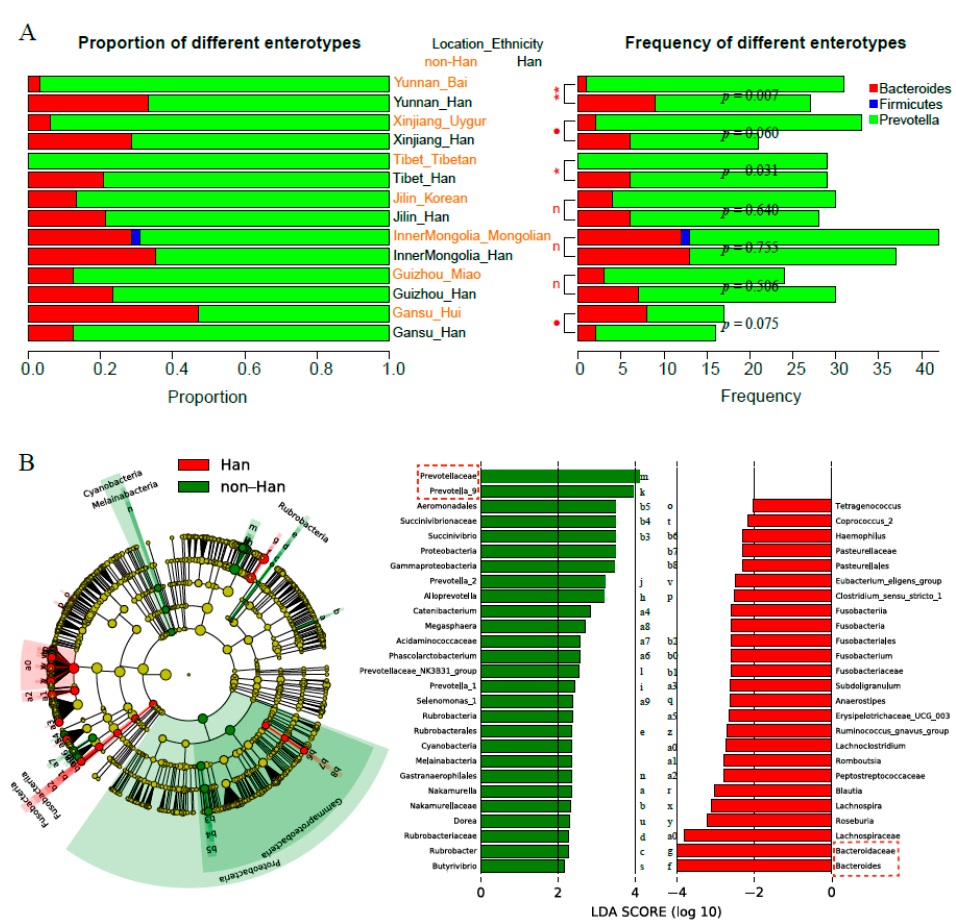
Figure 3. ( A ) Gut microbiota structures were divided into three enterotypes, Prevotella (ETP); Bacteroides (ETB); Firmicutes (ETF), based on their taxonomic composition at genus level; “ p ” represents the p -value of chi-square tests between two groups connected by longitudinal lines. **: 0.001 ≤ p < 0.01; *: 0.01 ≤ p < 0.05; • : 0.05 ≤ p < 0.1; n: p ≥ 0.1, no significant. ( B ) Plot_Cladogram of LEfSe analysis. Taxonomic representation of statistically and biologically consistent di ff erences between Han groups and non-Han groups. Di ff erences are represented in the color of the most abundant class (red indicating Han groups, green indicating non-Han groups and yellow non-significant). Each circle’s diameter is proportional to the taxon’s abundance. The genera, which is significantly di ff erent between Hans and non-Hans, and its taxonomic rank are both highlighted—for example, multiple di ff erentially abundant sibling taxa consistent with the variation of the parent clade; the right list of LEfSe provides features that were di ff erential among conditions of interest with statistical and biological significance, ranking them according to the e ff ect